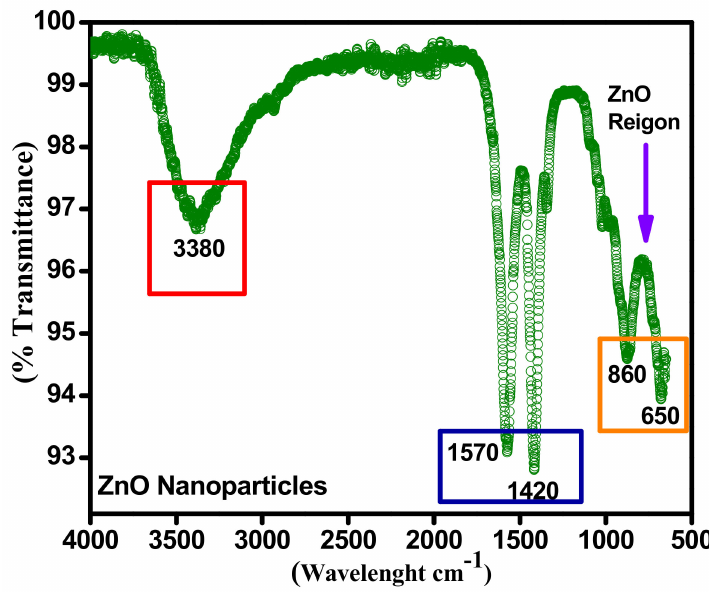
Figure 7. FTIR spectra confirmation of